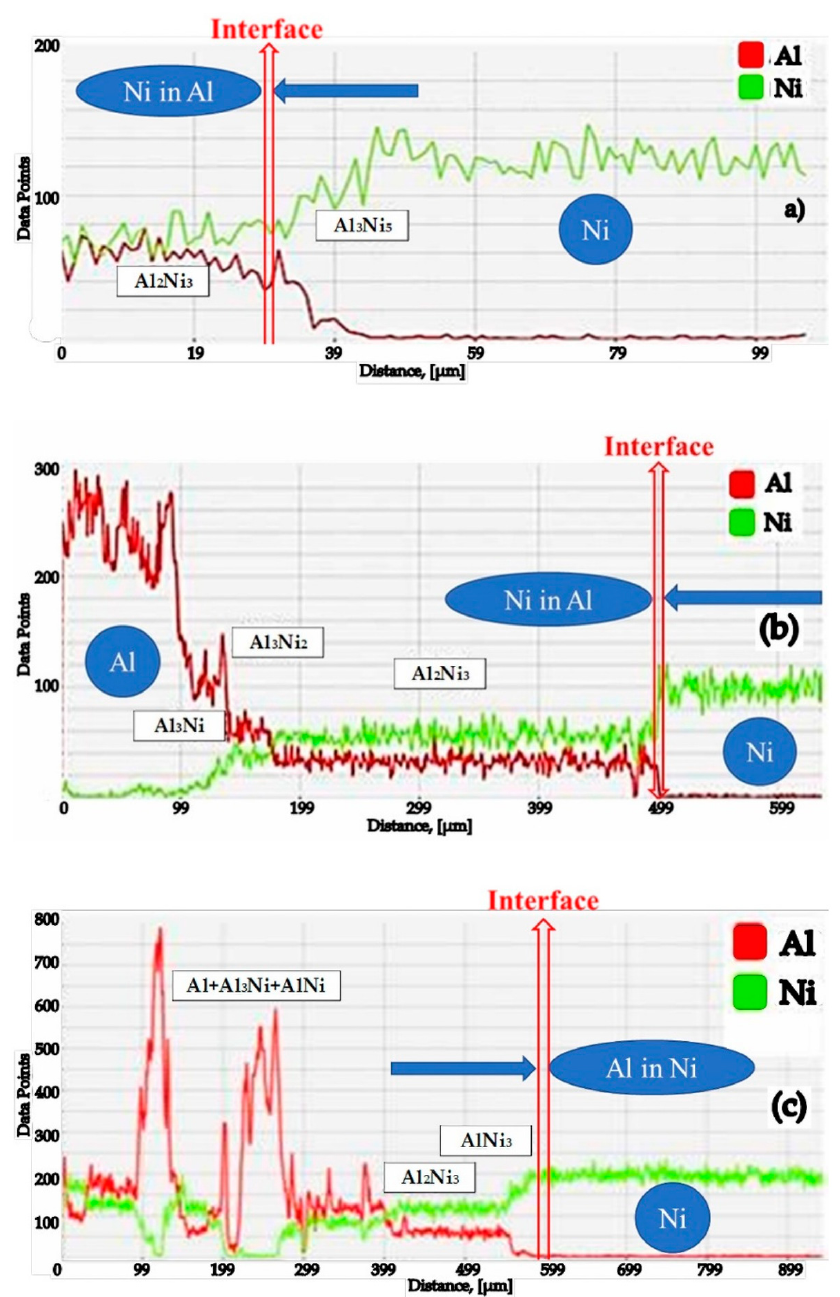
Figure 3. The effects of Ni cementation in the pack cementation process (50 wt.% Al + 49 wt.% Al 2 O 3 + 1 wt.% NH 4 Cl), at 650 °C for 20 h ( a ) and at 1000 °C for 20 h ( c ); Al and Ni distribution in the Al-Ni diffusion couple at 100 KPa and at 650 °C for 50 h ( b ).